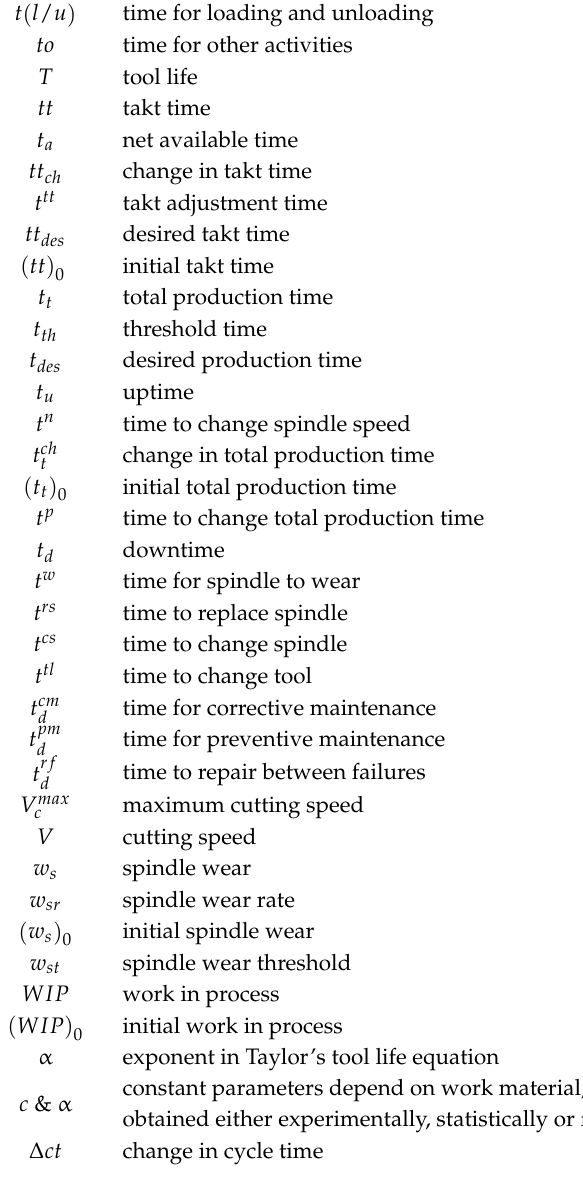
obtained either experimentally, statistically or from published